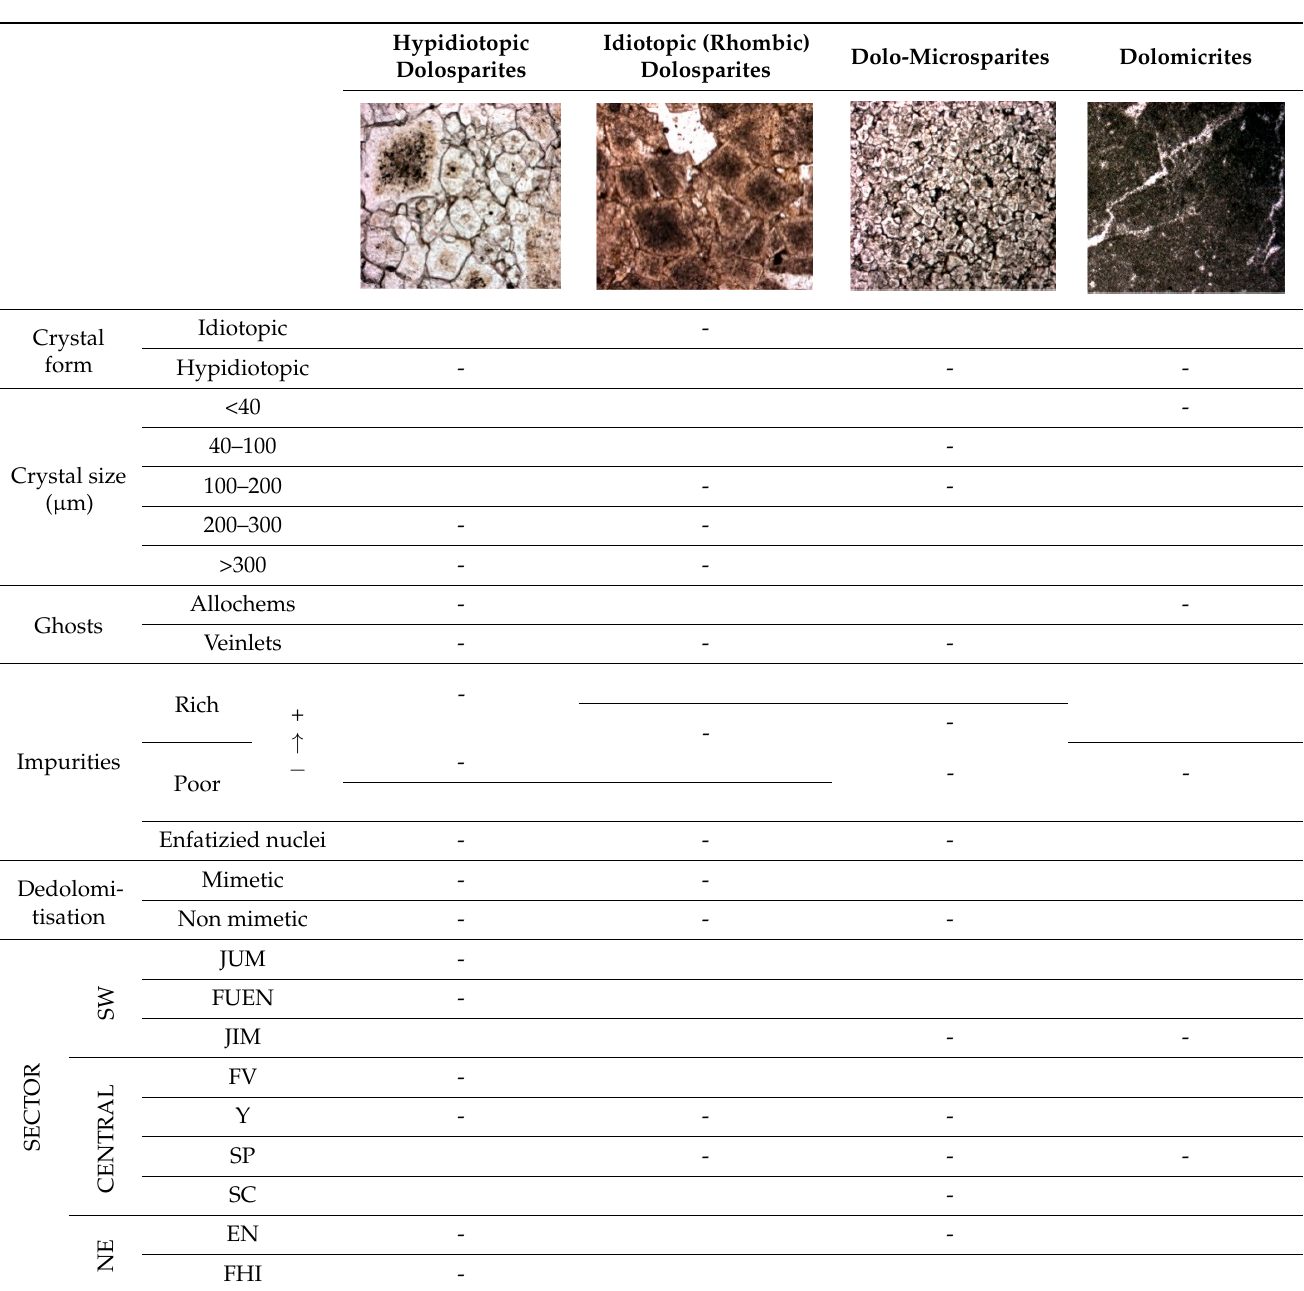
Table 2. Main features of dolostone petrofabrics and their distribution in the study area.